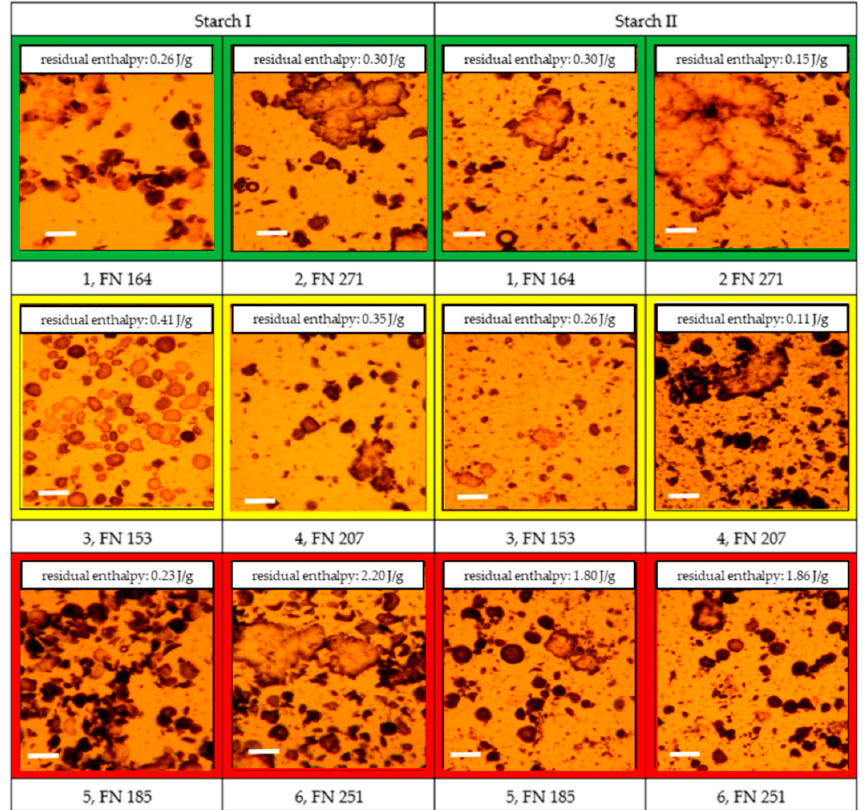
Figure 7. Pentosan and glucan contents in the Starch II phase of the selected samples, depending on “good” to “medium” to “poor” baking quality and the corresponding falling number (FN) within the individual baking quality classes (here: first samples were always assigned the lower FN and second samples the higher FN). Sample description: see Table 1. Bars represent the mean value of two replicates; error bars represent the confidence interval.